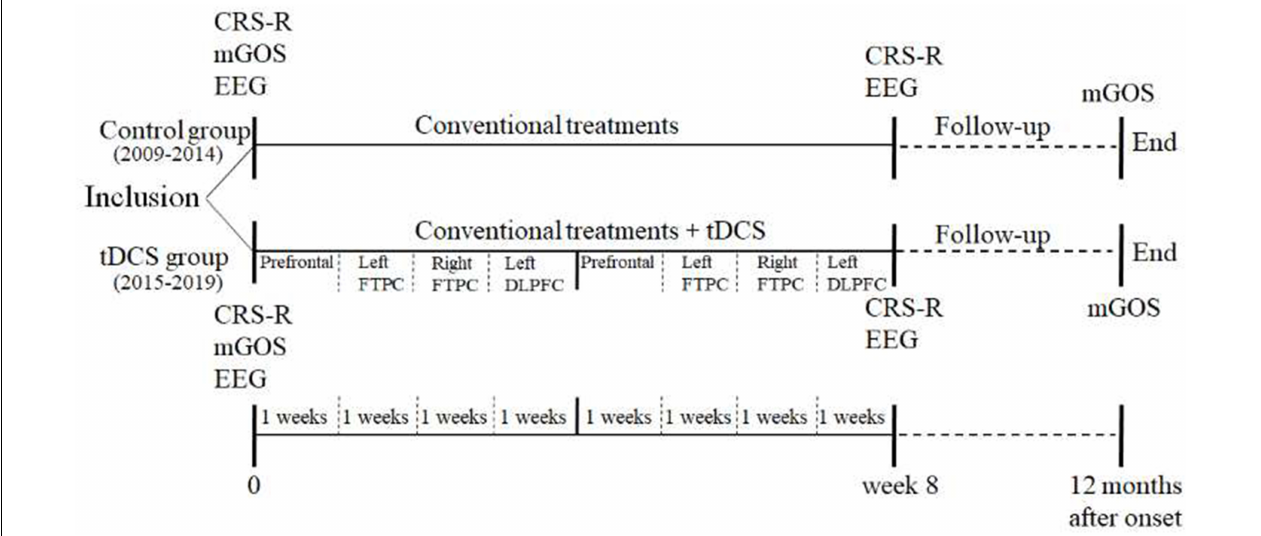
FIGURE 1 | Study protocols.